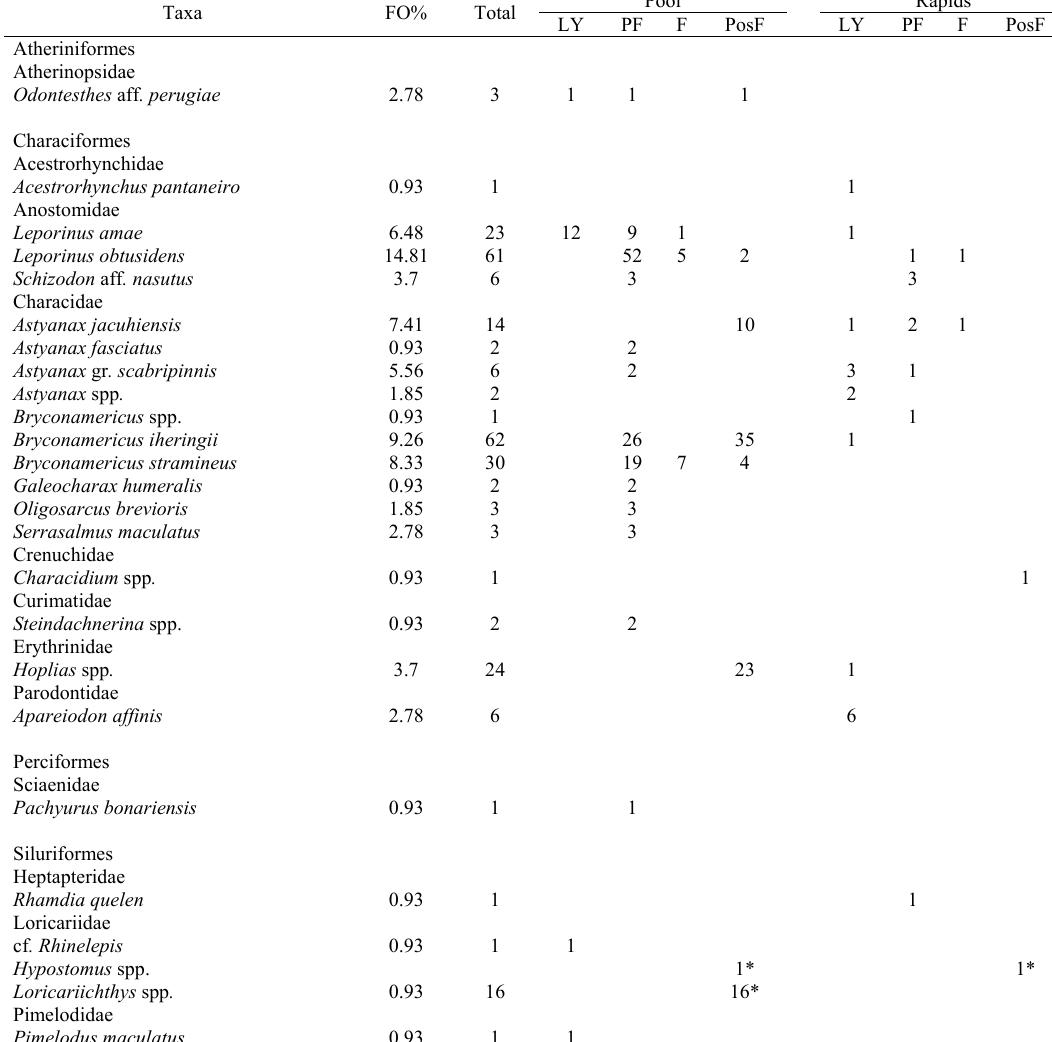
Table 1. Occurrence frequency (FO%) and average density of fish larvae in the different sampling sites captured with light traps in the Peixe River between October 2011 and March 2012 (R - rapids environment; P - pool environment; total - total larvae captured; LY - larval yolk; PF - preflexion; F - flexion; PosF - postflexion). * values correspondent to individuals measuring up to 40 mm in